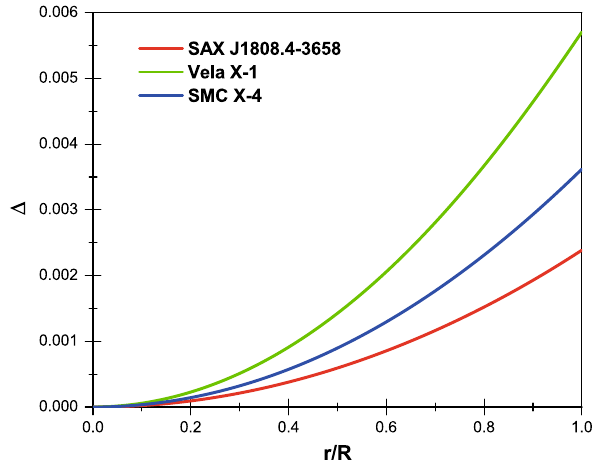
Fig. 2 Theanisotropyfactor Δ againstthefractionalradiusfor α = 0 .